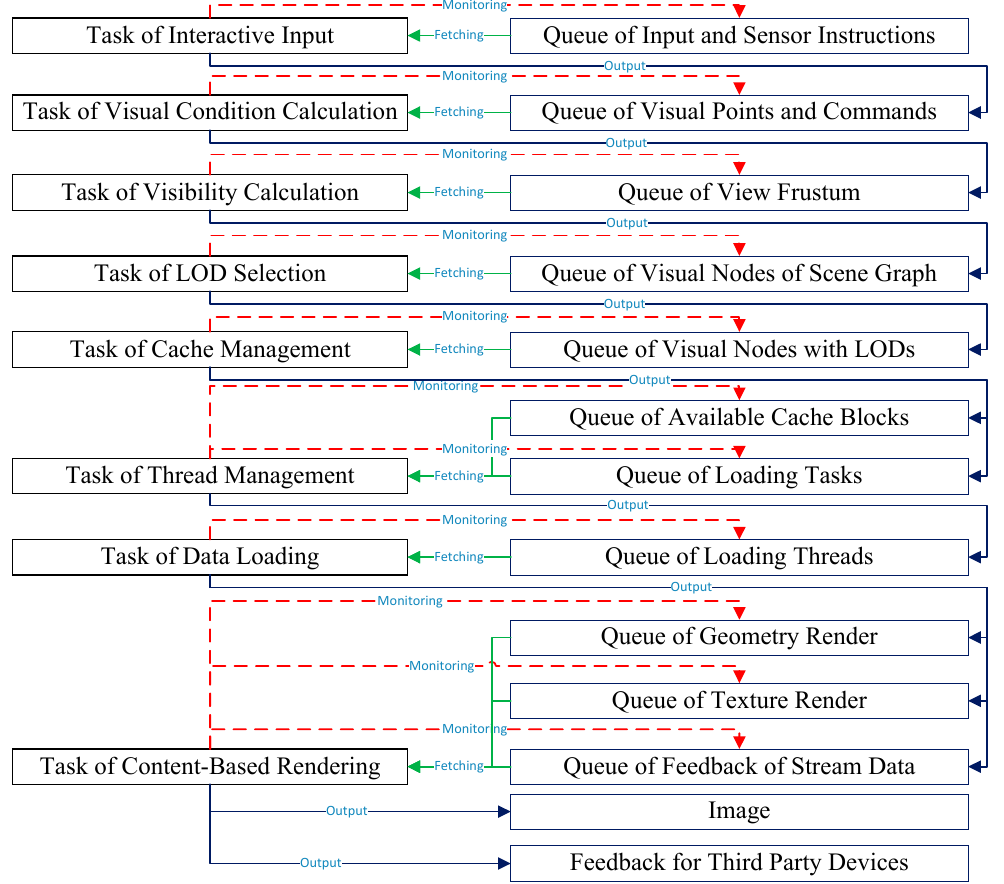
Figure 3. The synchronization of tasks based on data queue.